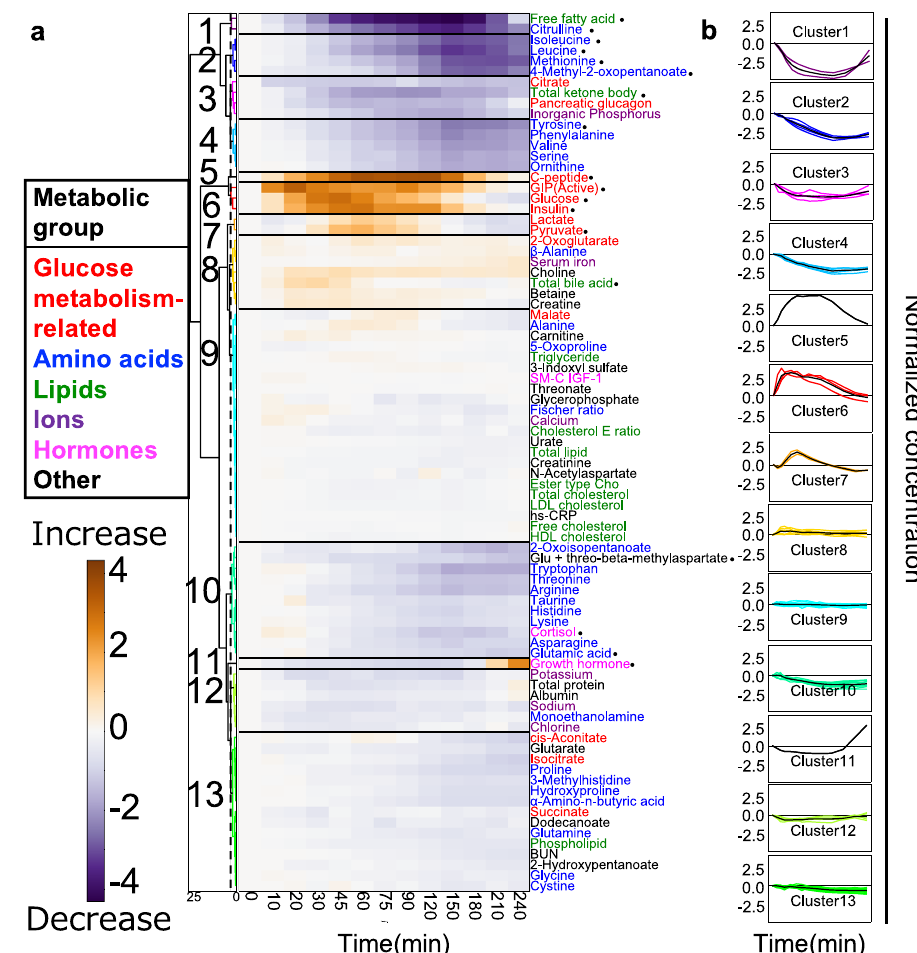
Fig. 2 Classi fi cation of the temporal patterns of molecules. a Heat map of the normalized time course of 83 molecules. Molecules are ordered by hierarchical clustering using Euclidean distance and Ward ’ s method. The colours and numbers on the tree diagram indicate the cluster that each molecule belongs to. The dashed line indicates the threshold for dividing the cluster. The colours assigned to the names of molecules correspond to the metabolic group (inset). The circles indicate 18 glucose-responsive molecules that showed a signi fi cant change by glucose ingestion (Supplementary Fig. 2). b Averaged time courses (in minutes (min)) of the molecules for all 13 clusters. The panels show average (thick line) and individual (thin line) time courses of the molecules in a cluster. We performed hierarchical clustering of normalized time courses of 83 molecules. The time courses were divided into 13 clusters characterized by the difference of the temporal pattern of the molecules. We de fi ned the amplitude of the temporal changes of the cluster as large (molecules whose absolute values exceed 2.5, even if just one instance), small (between 1.5 and 2.5), or not clear (<1.5). We also de fi ned transient and sustained patterns of clusters; transient patterns of clusters included molecules that returned to 50% of their maximum values during the time courses; all others were sustained. Note that “ Normalized concentration ” is dimensionless. Abbreviations for the molecules are as follows: GIP (active) gastric inhibitory polypeptide (active), SM-C IGF-1 somatomedin-C insulin-like growth factor I; ester type Cho ester type cholesterol, HDL cholesterol